Question: What does this figure show? Answer in one sentence.
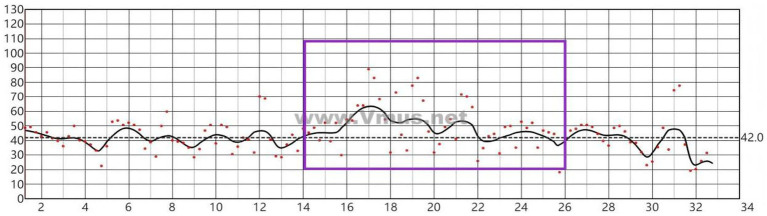
Answer: Sviatoslav Richter Macro Tempo Curve.